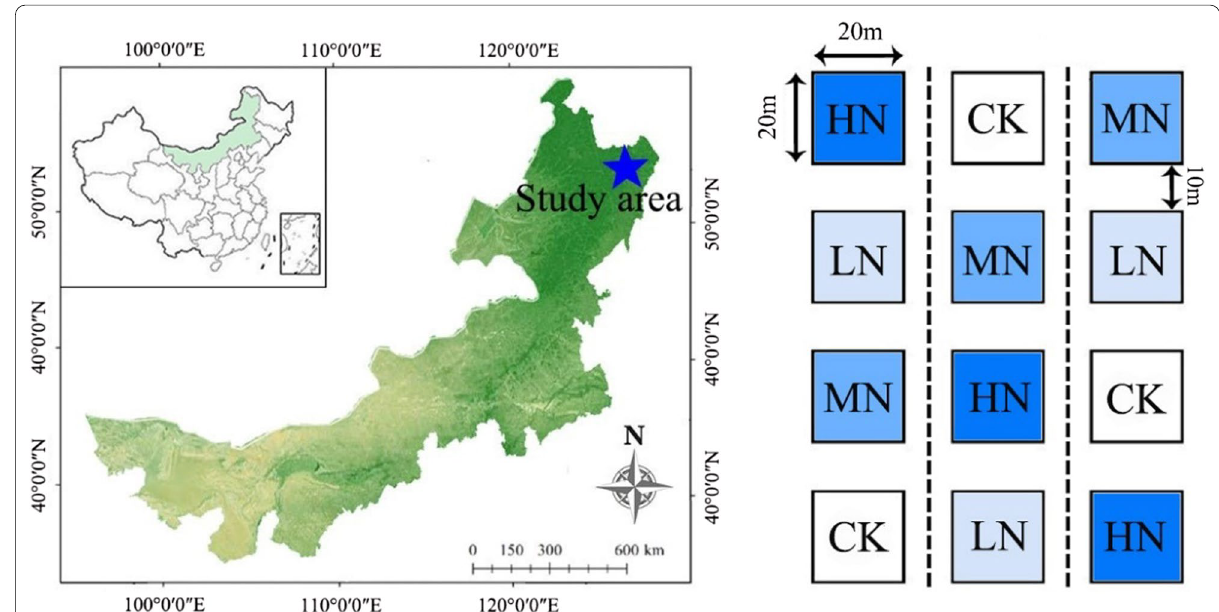
Fig. 1 Diagram of the experimental design in the Greater Khingan Mountains northeastern China. CK, LN, MN, HN represent the control, low N treatment, medium N treatment, and high N treatment,